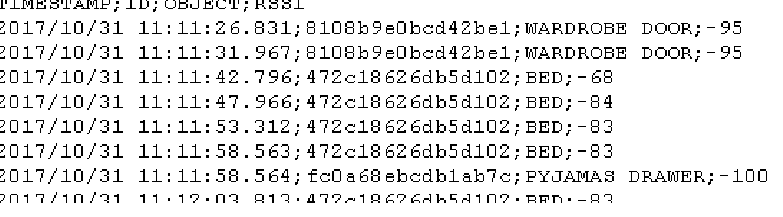
Figure 10. Excerpt from a proximity.csv